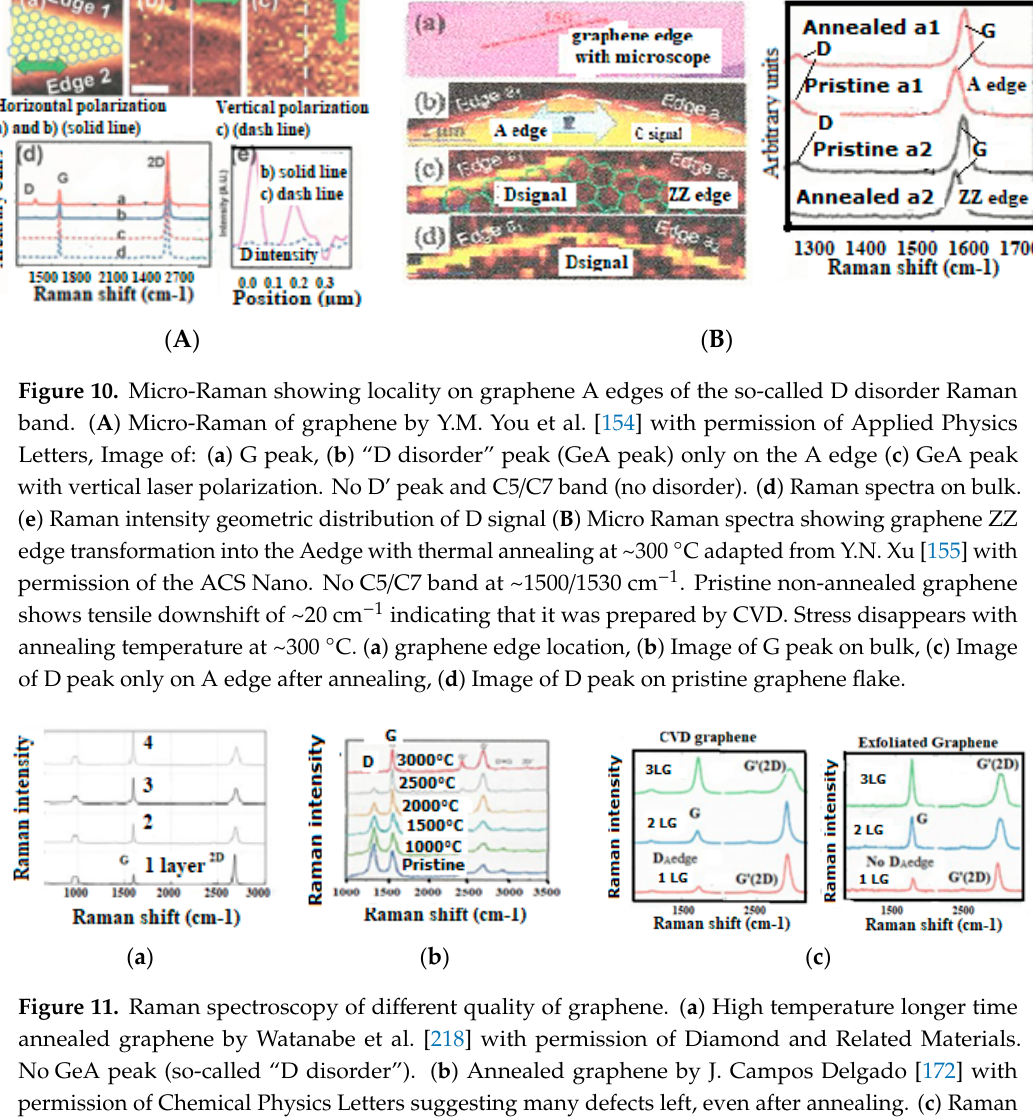
Figure 12. Graphene edge analysis of cut graphene plane and scheme of edge modification. ( a ) Raman spectra of cut graphene by Cançado et al. [222] by permission of the Physics Review Letters. D (1333 cm − 1 ), D disorder peaks: GeA (~1350 cm − 1 ) and D’ disorder Csp2-Csp2 (~1620 cm − 1 ) are shown. Sharp G peak means that no disorder exists on hexagonal sp2 rings. ( b ) Our proposed scheme of graphene cut edge with the formation of sp3, single and double dangling Csp2-Csp2 corresponding to D diam, D’ and 2D’ peaks. ( c ) Our proposed scheme of voids formation associated to the thermally induced ZZ edge transformation into the A edge with internal ZZ and A edges on formed voids. However, in order to know more accurately the carbon structure of the material it is necessary to know to which structure the D peak corresponds and to consider the different types of subsystems including Csp3-Csp2 (~1520 cm − 1 and ~1470 cm − 1 ) [26,117,182], Diamond edge Csp3-Csp3 bonds ( often designated T band) ~1100 cm − 1 , H6 sp3 hexagonal Diamond ~1325 cm − 1 , D crystalline diamond/D amorphous diamond band ~1330 cm − 1 [26,113,173]. Edge dangling bonds Csp2-Csp2 (so- called D’ peak) ~1620 cm − 1 ) [170,222,223] (same IR and Raman frequency), C5/C7 odd rings ~1520/1550 cm − 1 [224] (Table 1). For this achievement some revised aspects of the carbon Raman spectroscopy fundamentals are suggested to bring clarification and we recall next. 5.4. Refined Carbon Raman Spectroscopy The classical Raman theory [225] has been refined with quantum mechanical aspects involving phonon modes distribution (Figure 13) and photon/electron/phonon scattering represented in the reciprocal space [150,151,226,227]. The Raman frequency corresponding to the homogeneous and ordered bulk structure could be satisfactorily calculated for diamond [189,190] and graphene